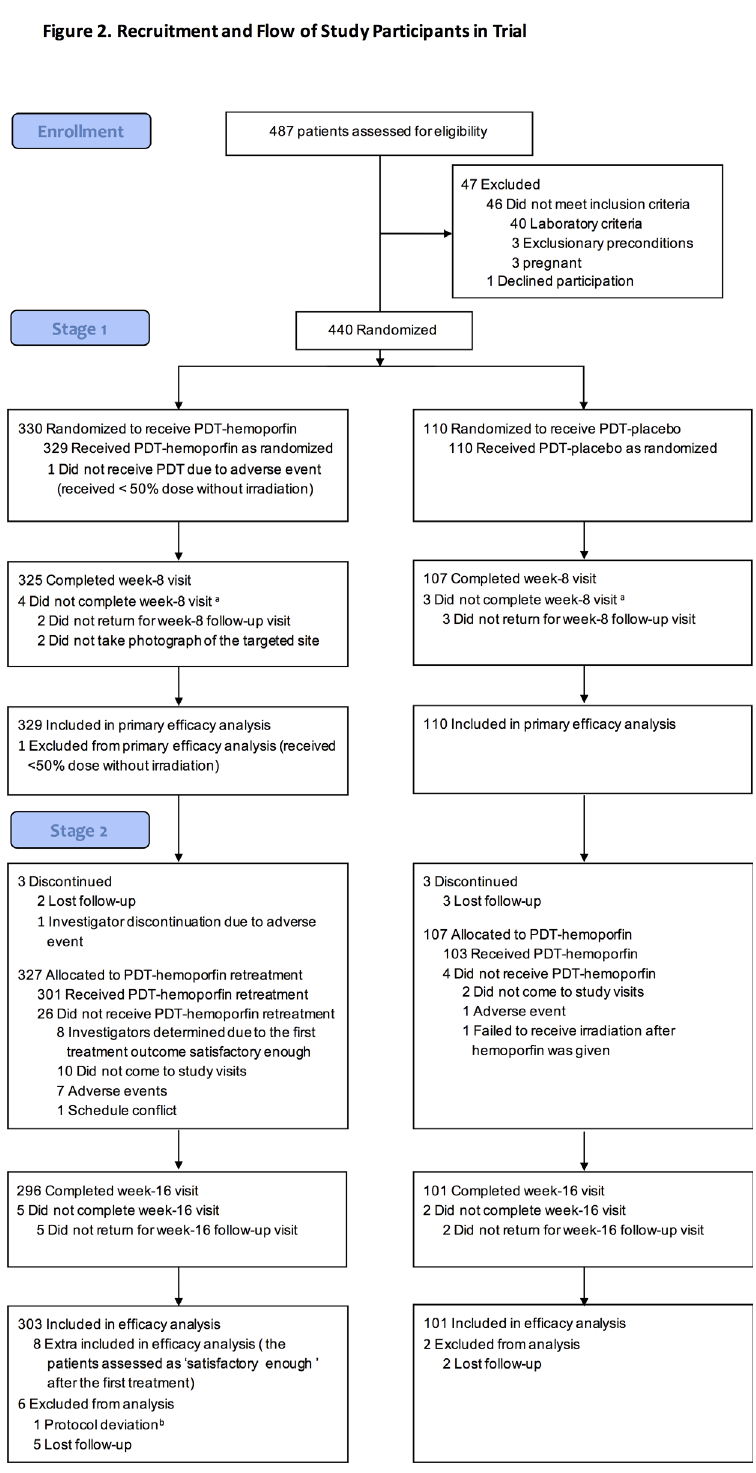
Fig 1. Flowchart of patient enrollment, treatment group allotment, and progression through the study period. Abbreviations: PDT-hemoporfin, hemoporfin-mediated PDT; PDT-placebo, laser irradiation plus placebo. Denotations: a Data from participants were included in the primary efficacy analysis, missing data were imputed as no improvement. b A different area of the targeted lesion was treated.